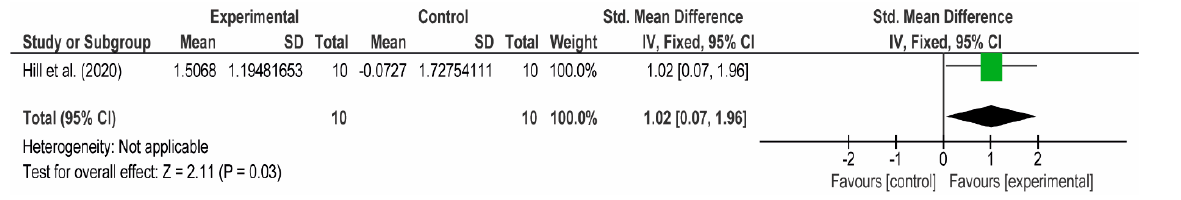
Figure 14. The effect size of 4-weeks of concentric low-load (at 30% of concentric elbow flexion peak Figure 14. The effect size of 4- weeks of concentric low-load (at 30% of concentric elbow flexion peak Figure 14. The effect size of 4- weeks of concentric low-load (at 30% of concentric elbow flexion peak Figure 14. The effect size of 4- weeks of concentric low-load (at 30% of concentric elbow flexion peak Figure 14. The effect size of 4- weeks of concentric low-load (at 30% of concentric elbow flexion peak torque) forearm flexion-extension training with vBFR (40% of lowest pressure needed to restrict torque) forearm flexion-extension training with vBFR (40% of lowest pressure needed to restrict torque) forearm flexion-extension training with vBFR (40% of lowest pressure needed to restrict torque) forearm flexion-extension training with vBFR (40% of lowest pressure needed to restrict torque) forearm flexion-extension training with vBFR (40% of lowest pressure needed to restrict brachial artery) on increasing the biceps brachii MT. brachial artery) on increasing the biceps brachii MT. brachial artery) on increasing the biceps brachii MT. brachial artery) on increasing the biceps brachii MT. brachial artery) on increasing the biceps brachii MT.